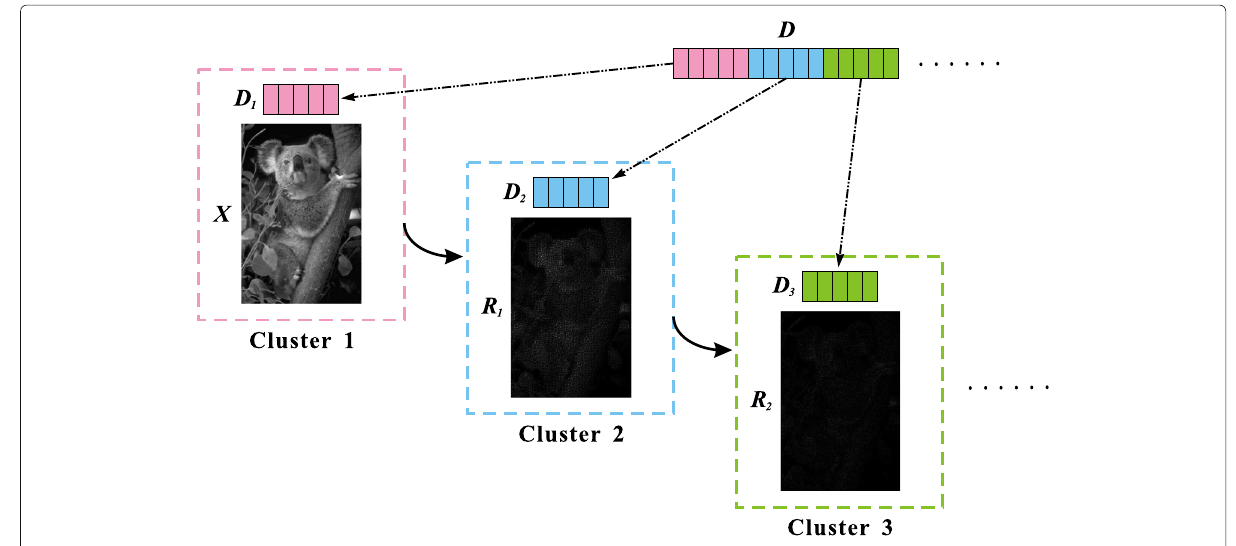
Fig. 4 Sparse recovery using the proposed